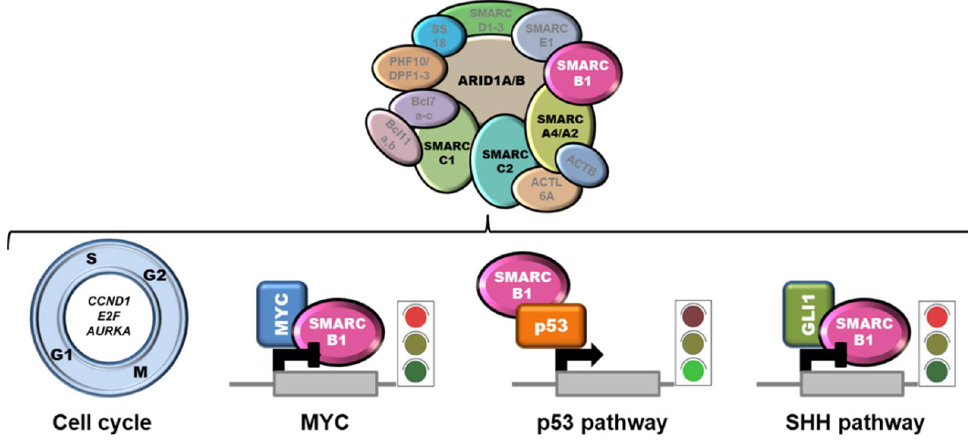
Figure 2. SMARCB1 intersection with relevant pathways. SMARCB1 negatively controls the expres- sion of several cell cycle-related genes. Moreover, by interacting with MYC or GLI1, it hampers their transactivation activity. Conversely, the binding to p53 potentiates p53 tumor suppressive activity. The loss of the SWI/SNF subunits ARID1A, SMARCC1, SMARCC2, and SMARCA4 (in black) has been claimed to play a pathogenic role in the small fraction of SMARCB1-proficient ES.